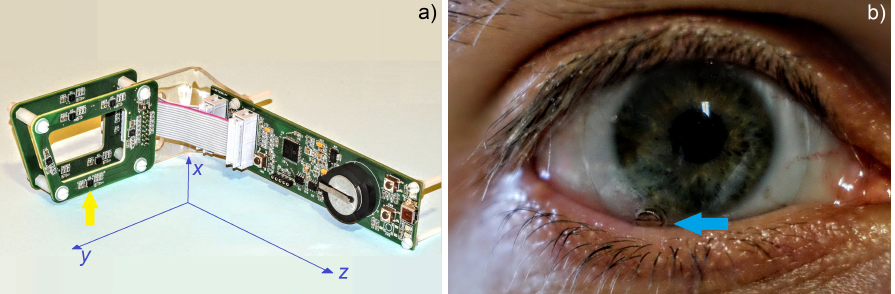
Figure 1. The sensor array—at the left side of image ( a )—contains eight three-axial magnetoresis- tive sensors (one of which is indicated by the yellow arrow) distributed on two parallel printed circuit boards (PCB) displaced by ∆ z = 16.6 mm). A third PCB—at the right side of the image ( a )—hosts a microcontroller and other electronics necessary to store data during preliminary cali- bration procedures and to communicate with a personal computer via a USB interface. The system is designed to localize a small magnet—pointed out by the blue arrow in the image ( b )—which is inserted in a scleral lens to be worn by the